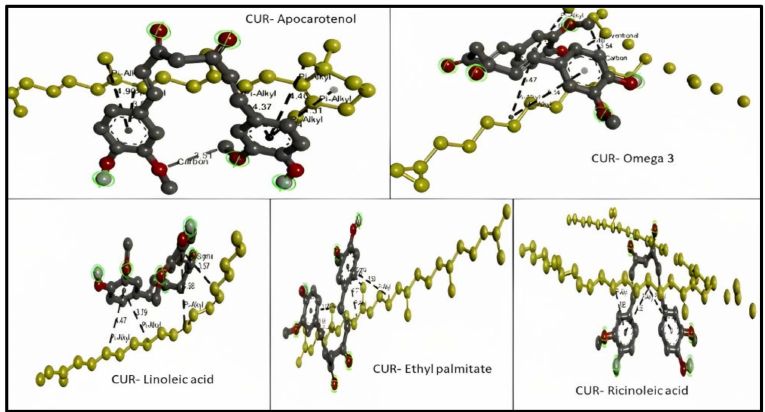
Figure 1. 3D molecular interaction between curcumin (CUR) with different liquid lipids (highlighted in yellow) for solubility prediction. The formed bonds are described as black short lines.